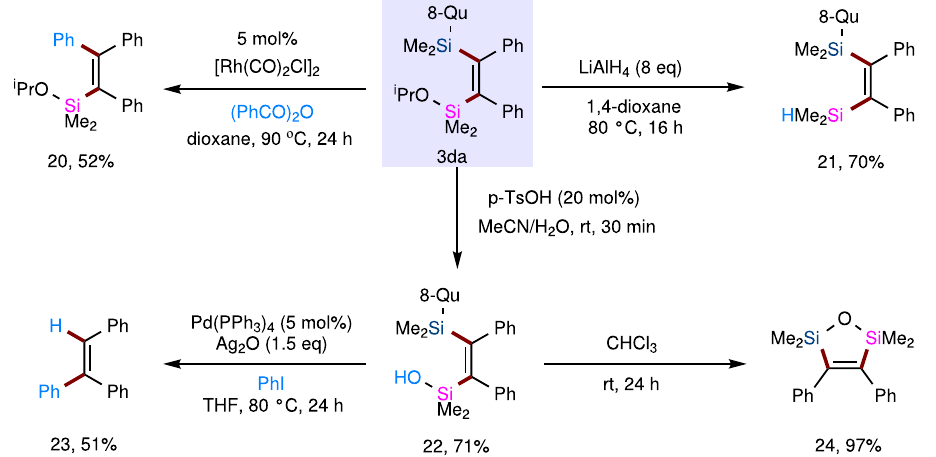
Fig. 7 Synthetic utility of product 3da. These results indicate that the two vicinal silyl substituents on product 3da can be suf fi ciently differentiated in downstream transformations to achieve structurally diverse skeletons. Yields are for isolated and puri fi ed products. The detailed procedures for these downstream transformations have been presented in Supplementary Information